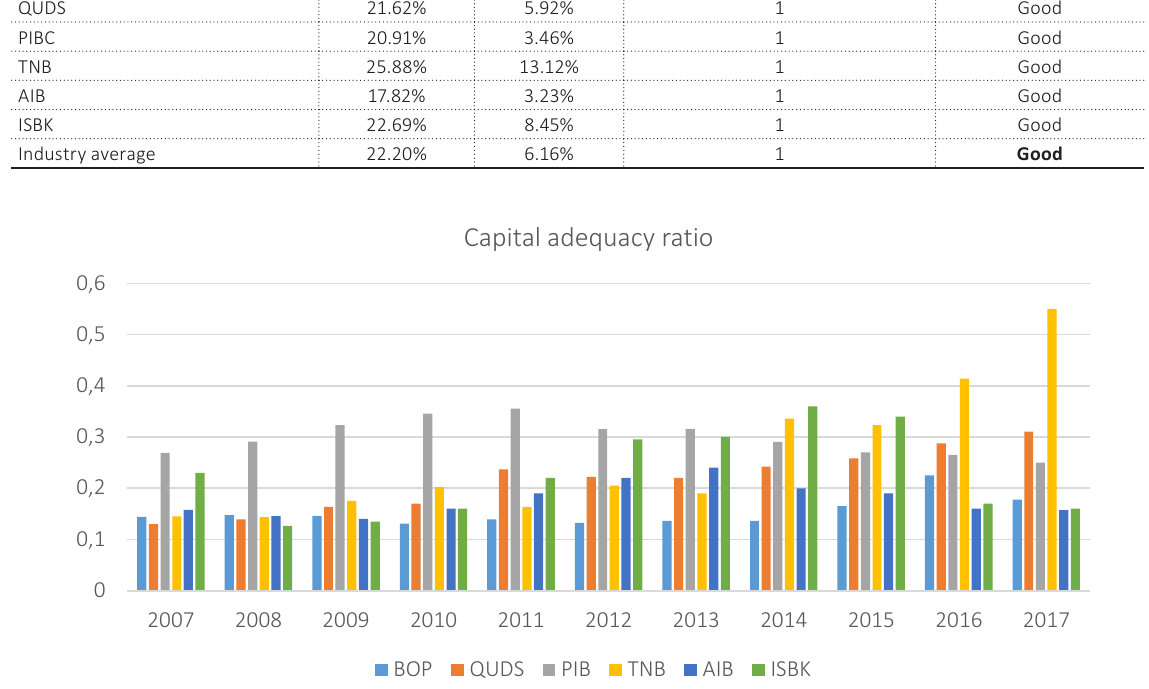
Figure 1. Capital adequacy ratio for the listed banks